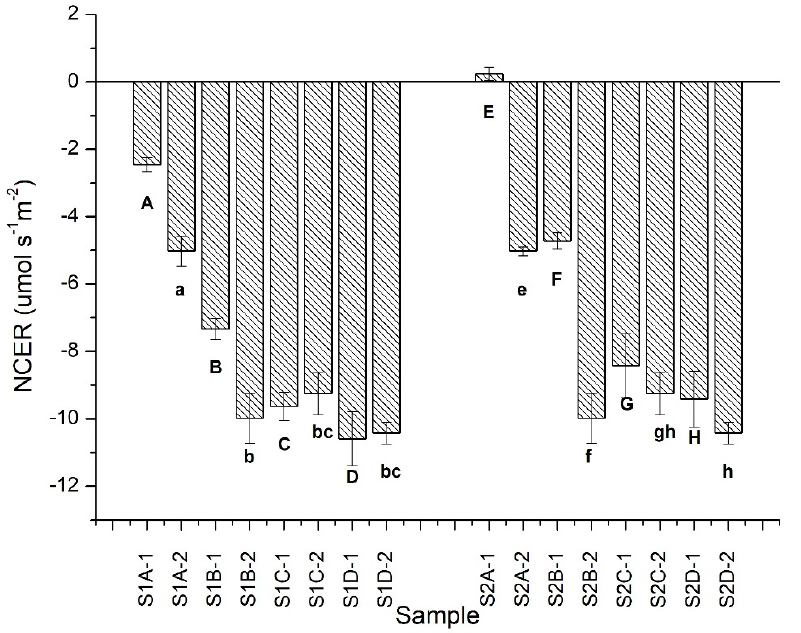
Figure 3. Net CO 2 emission rate (NCER) in the studied soils. S1: soil from the limestone open-cast mining remediated with embankment; S2: soil from the lignite open-cast mining remediated with sewage sludge; subsequent letters A–D mean different remediated areas located at the same mine; subsequent numbers mean different sampling periods; 1: spring 2021, 2: spring 2022. Mean values ± SD, n = 3. Different letters with bars indicate significant differences between tested treatments ( p < 0.05) according to Tukey’s test. Small and large letters indicate separate analyses for both sampling soils.